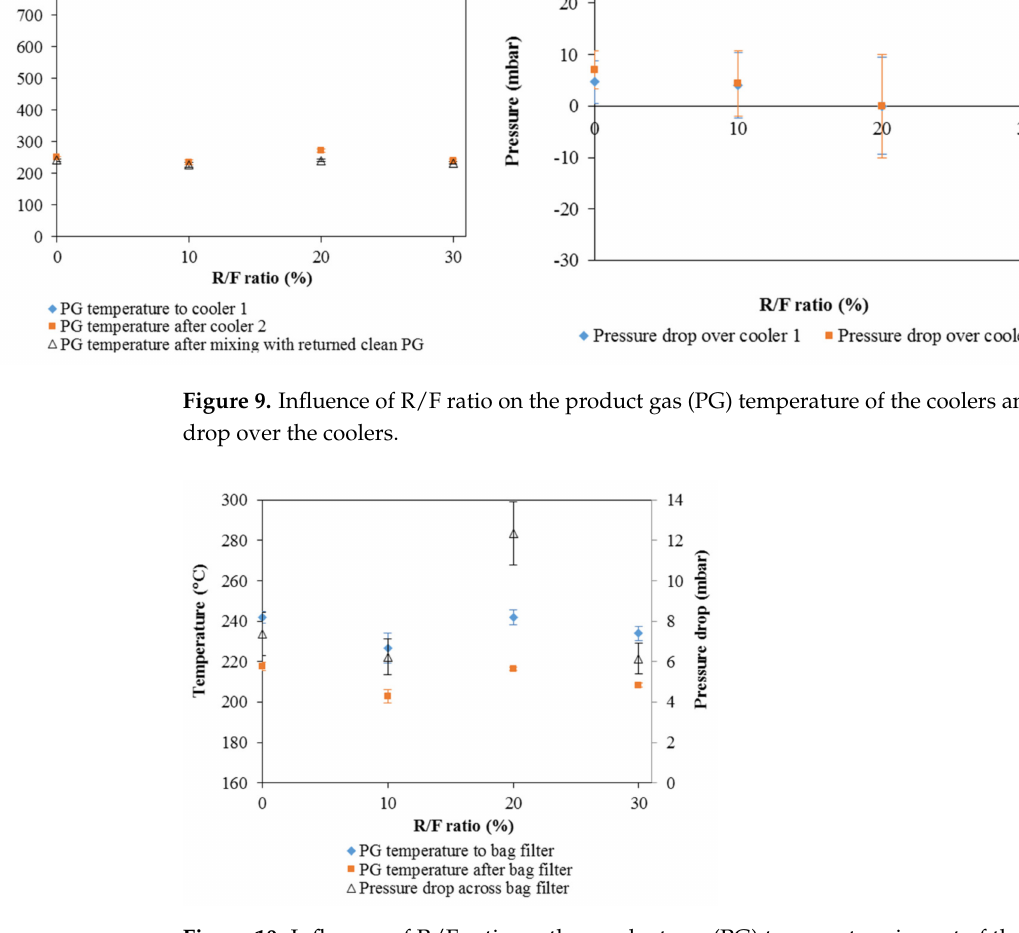
Figure 10. Influence of R/F ratio on the product gas (PG) temperature in–out of the bag filter and pressure drop across the bag filter.